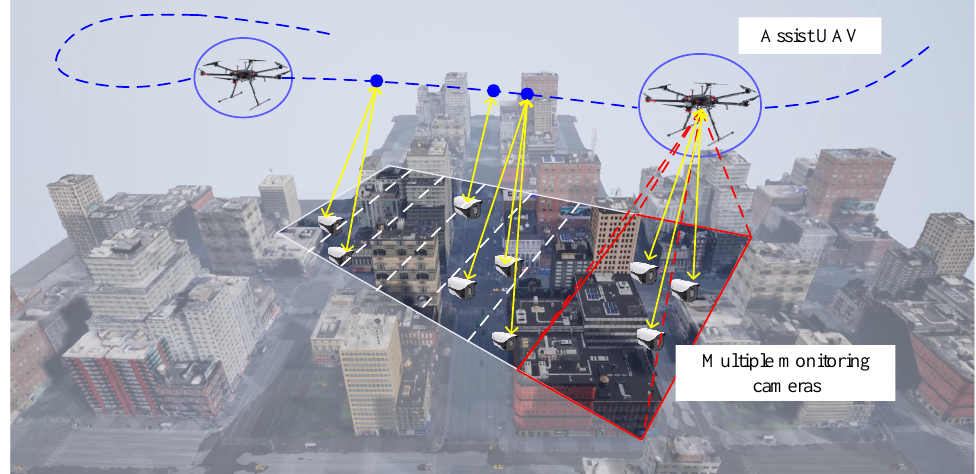
Figure 1. An illustration of UAV-assisted wide area multi-camera space alignment. Through air-to- ground matching based on spatiotemporal feature map, the relative relationship between UAV and ground cameras is obtained (yellow line). Since we can unity the UAV’s external parameters (blue line), multiple cameras in a large-scale environment are aligned into one coordination system with UAV auxiliary linkage effectively and